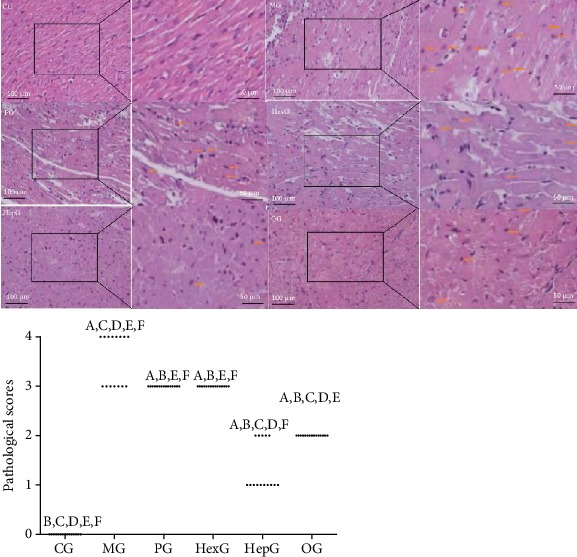
H&E analysis of myocarditis injury. (a) Control group (CG). (b) Model group (MG). (c) Chitopentaose-treated group (PG). (d) Chitohexaose-treated group (HexG). (e) Chitoheptaose-treated group (HepG). (f) Chitooctaose-treated group (OG). Ap < 0.05 vs. the CG group, Bp < 0.05 vs. the MG group, Cp < 0.05 vs. the PG group, Dp < 0.05 vs. the HexG group, Ep < 0.05 vs. the HepG group, and Fp < 0.05 vs. the OG group. n = 8 for each group.